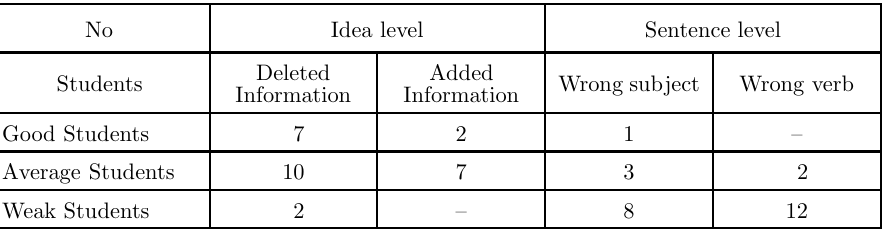
Distortions in different levels in the